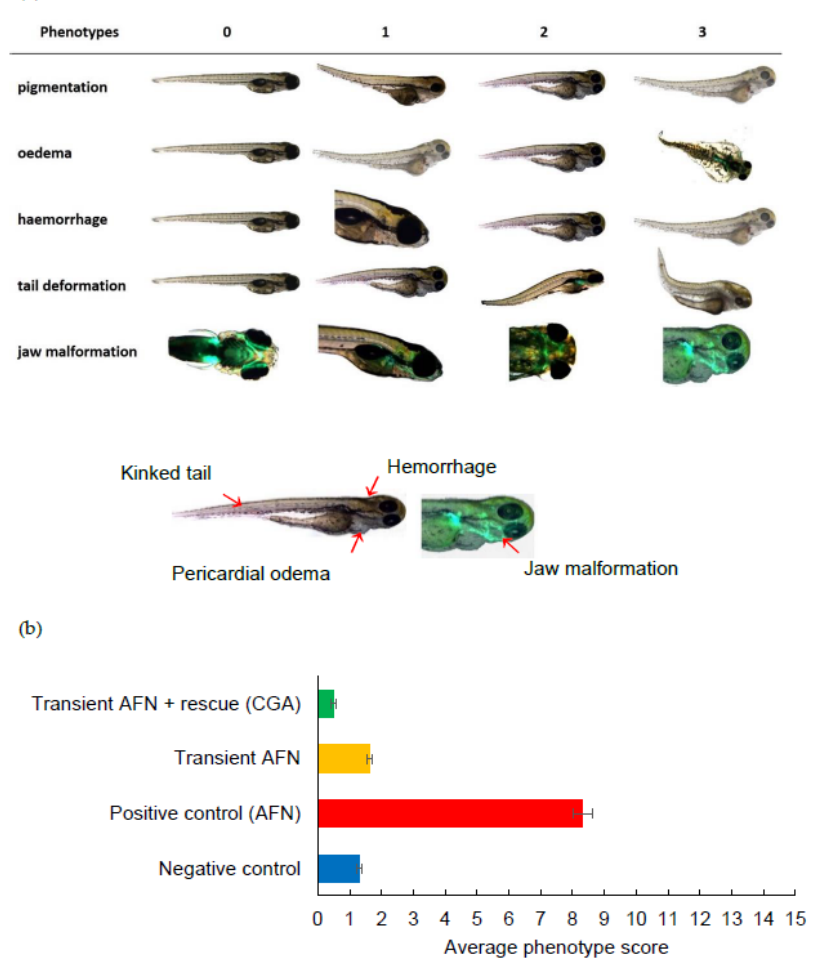
Figure 2. ( a ) Visual scoring chart for phenotypic abnormalities in zebrafish larvae. Phenotype score 0 = healthy, 1 = mild, 2 = moderate, and 3 = severe malformations. ( b ) Average score for